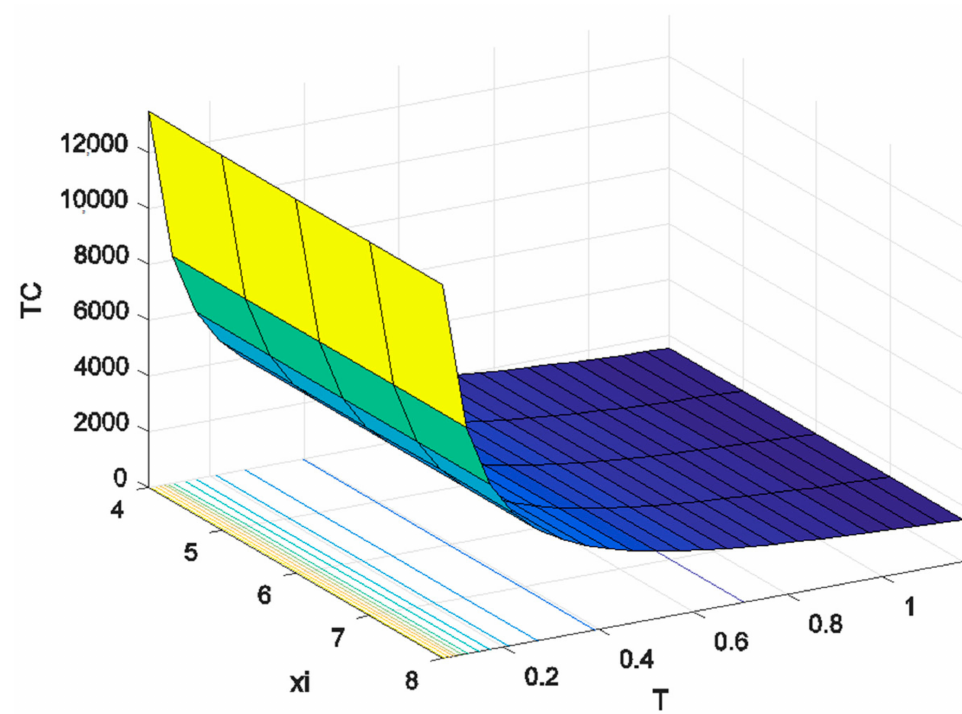
Figure 5. The relationship among T , ξ , and TC